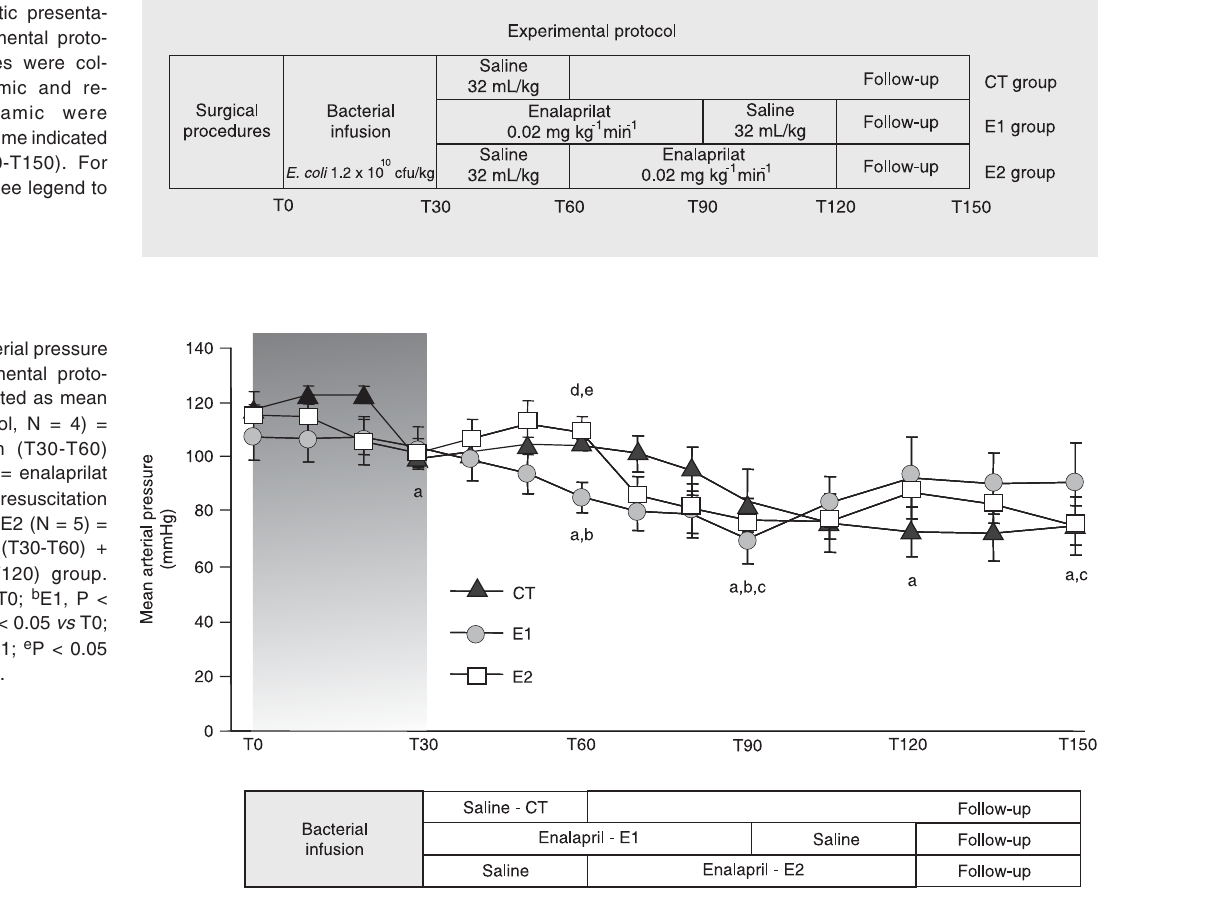
Figure 1. Schematic presenta- tion of the experimental proto- col. Blood samples were col- lected and systemic and re- gional hemodynamic were measured at each time indicated on the x-axis (T0-T150). For group definitions, see legend to Figure 2.